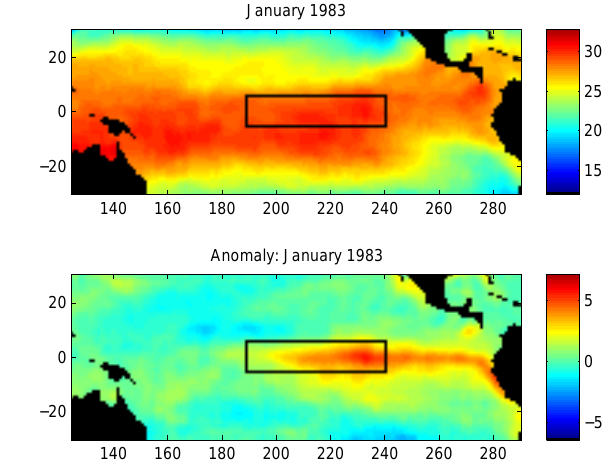
Figure 1. Comparison of the SST data to the SST anomaly data for January 1983. The climatology base period for the anomalies is 1971–2000. The Niño 3.4 region (5 ◦ S–5 ◦ N and 120–170 ◦ W) is inside the black rectangle. Units on the colour scale are ◦